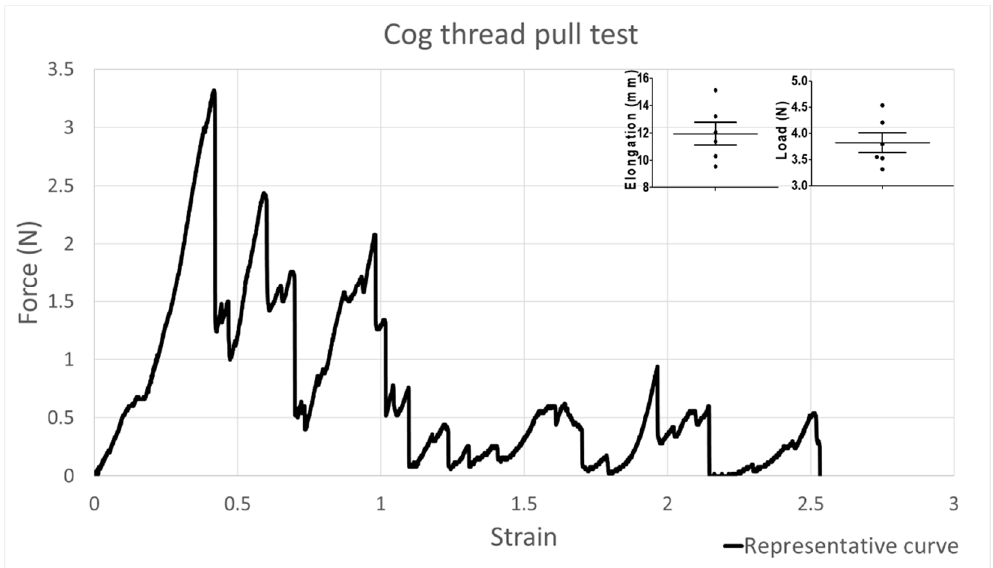
Figure 7. Representative force-strain curve of PCL cog thread pulling from the vaginal tissue. The top right bars represent force and elongation at this force at the first cog fixation failure during the pull-out test.